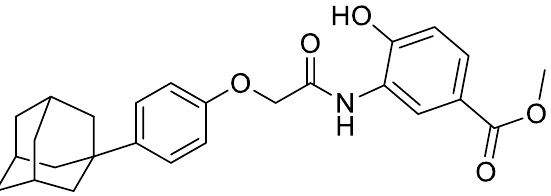
Figure 1. Structure of LW6 (3-[2-(4-adamantan-1-yl-phenoxy)-acetylamino]-4-hydroxy-benzoic acid methyl ester).